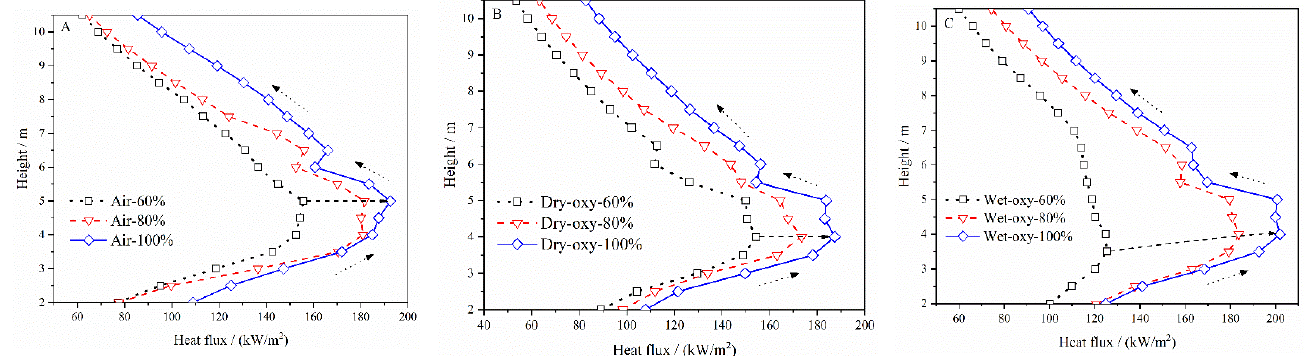
Figure 6. Heat flux distributions at 2.36 m wide at the three typical loads in air-firing ( A ), dry FGR ( B ), and wet FGR ( C ) conditions.